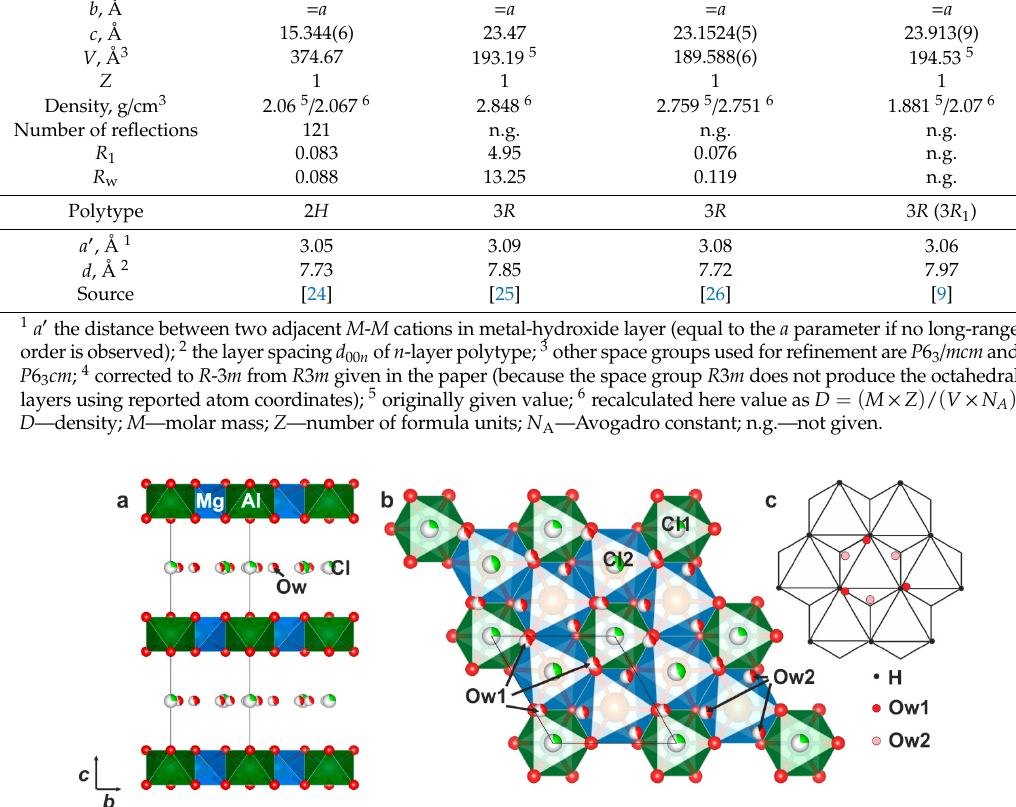
Figure 2. Projections of structure model proposed for chlormagaluminite by Kashaev and coauthors [24]: ( a ) along z ; ( b ) within xy plane, and ( c ) position of interlayer Ow1 and Ow2 ( z = 1/4) atoms relative to the hypothetic position of H atoms ( z ~ 0.12) of the metal-hydroxide